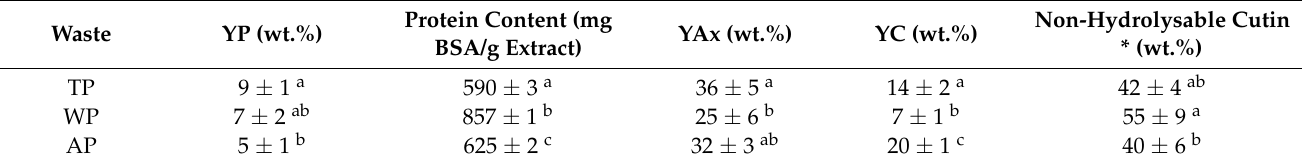
Table 1. Composition of the different fractions obtained in the cascade extraction process from different peel wastes ( n = 3, mean ± SD). Different superscripts in the same column indicate signifi- cantly different values ( p < 0.05). YP, YAx and YC are the extraction yields of proteins, antioxidant compounds and cutin,